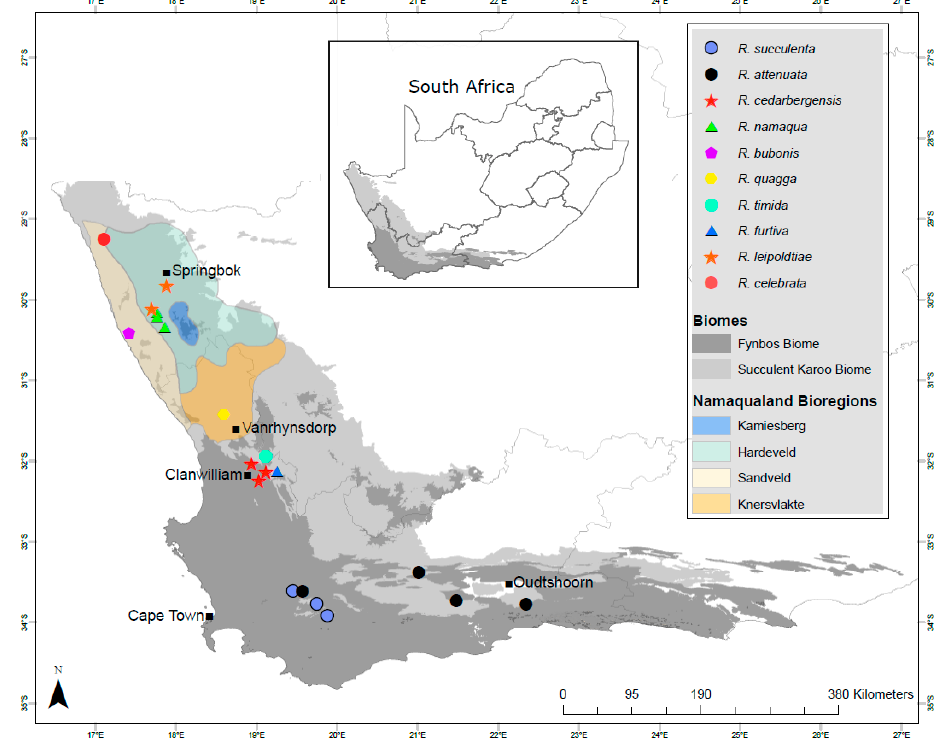
Figure 1. Sampling sites of the ten described Ruschiola species in the Fynbos and Succulent Karoo biomes of the Greater Cape Floristic Region of South Africa. Namaqualand bioregions are from Cowling et al. [8] (the northern bioregions of the Richtersveld and southern Namib Desert are not